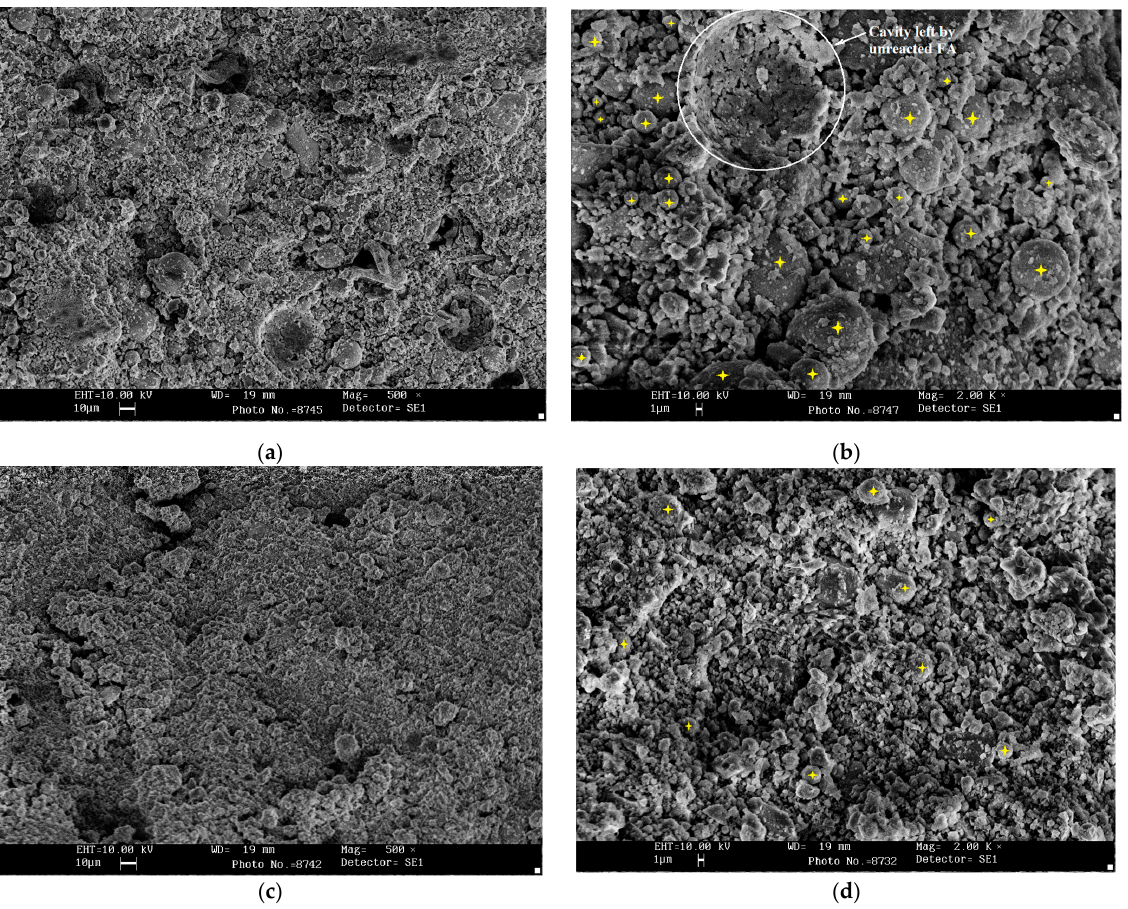
Figure 16. SEM images of the geopolymer synthesized using a (90% FA + 10% magnesite) blend mechanically activated for: ( a , b ) 30 s; ( c , d ) 180 s. Curing time was 28 d. In Figure 16b,d, unreacted FA spherical particles are marked with yellow crosses.